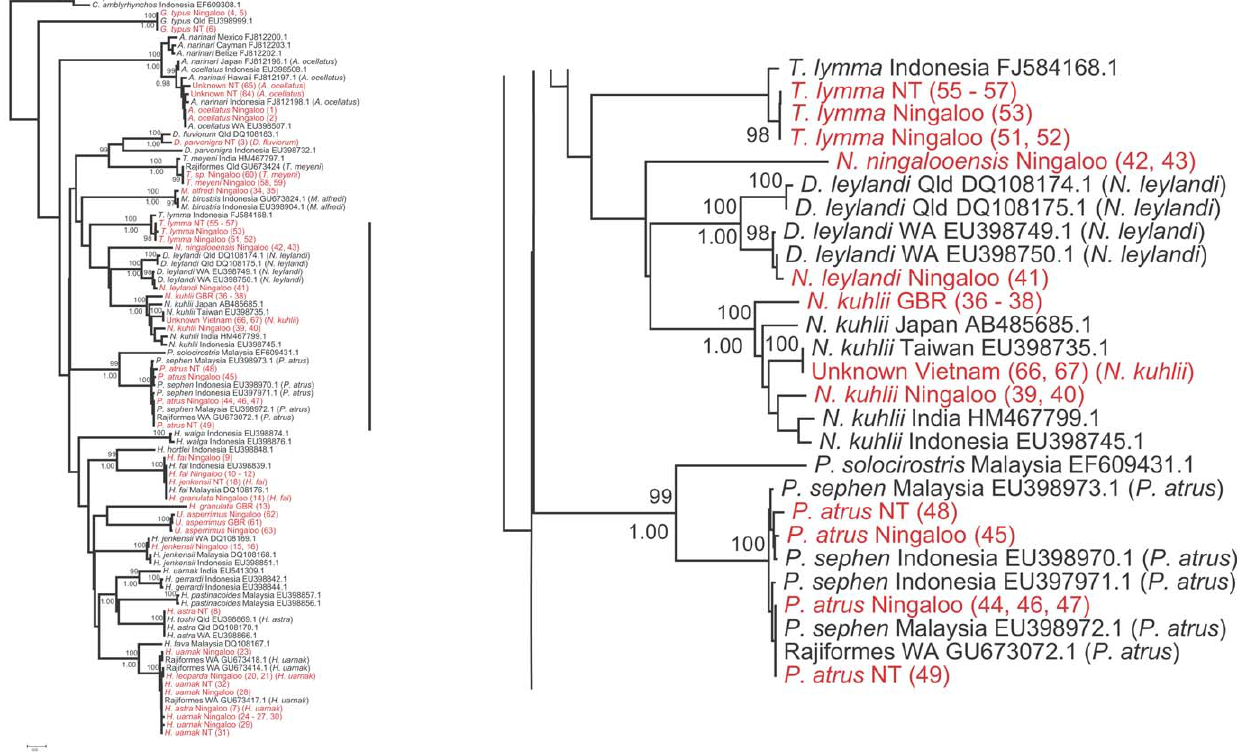
Figure 2. Phylogenetic relationship of rays Part II. Second part of the Neighbour-joining tree based on COI sequence data using Kimura-two- parameter substitution model (left); the second part of the tree (right). Names in red are the sequences obtained in this study, the corrected nomenclature is in () and given in Table S2.